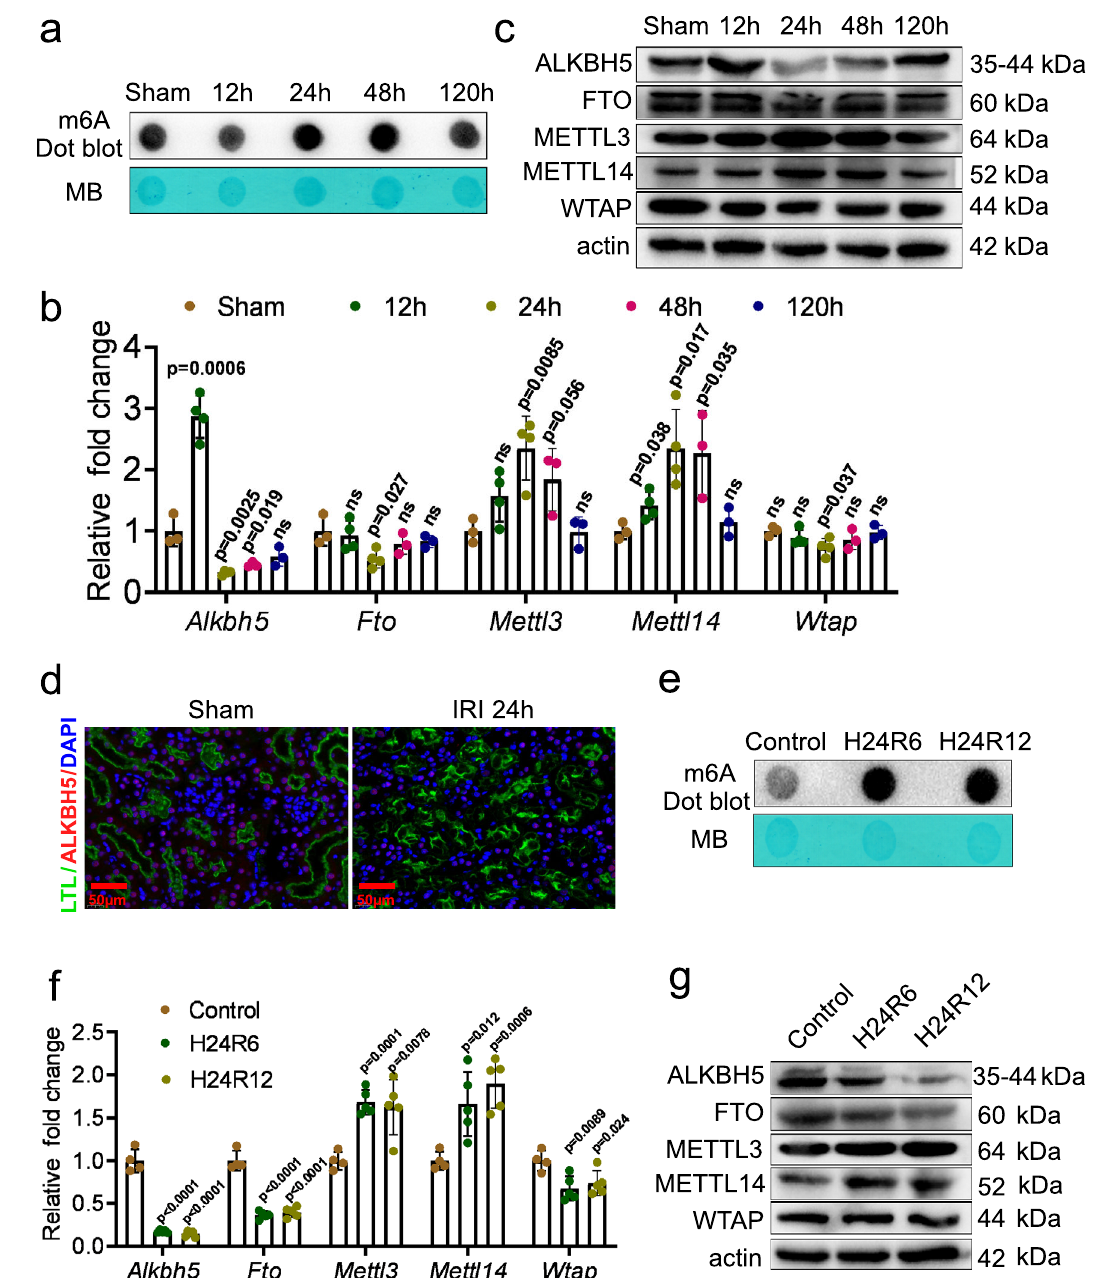
Fig.1|Them6Amodi fi cationwasinvolvedinrenalischemia-reperfusioninjury (IRI) and the hypoxia and reoxygenation (H/R) response in mouse renal tub- ular epithelial cells (mRTECs). a m6A dot blot assessed m6A mRNA methylation at different time in mouse IRI model. b Real-time quantitative PCR (RT-qPCR) analysisofm6Aregulators:AlkBhomolog5( Alkbh5) ,obesity-associatedgene( Fto) , methyltransferase-like protein 3 ( Mettl3 ), methyltransferase-like protein 14 ( Mettl14 ),andWilms ’ tumor1-associating protein( Wtap )inIRImodel. n =3,4,4,3, 3 for Sham, 12h, 24h, 48h, and 120h groups, respectively. Each data point represent one animal. Unpaired two-tailed Student ’ s t-test. c Western blot assay measured the protein levelsof m6A regulators (ALKBH5, FTO, METTL3,METTL14, and WTAP) in IRI kidneys. Three biological repeated immunoblots have been